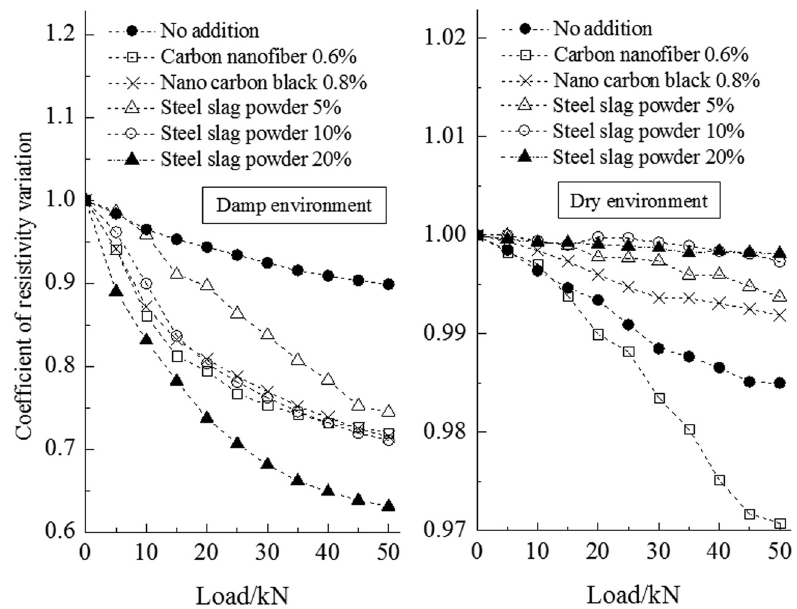
Figure 4: Relationship of load and coe ffi cient of resistivity variation of